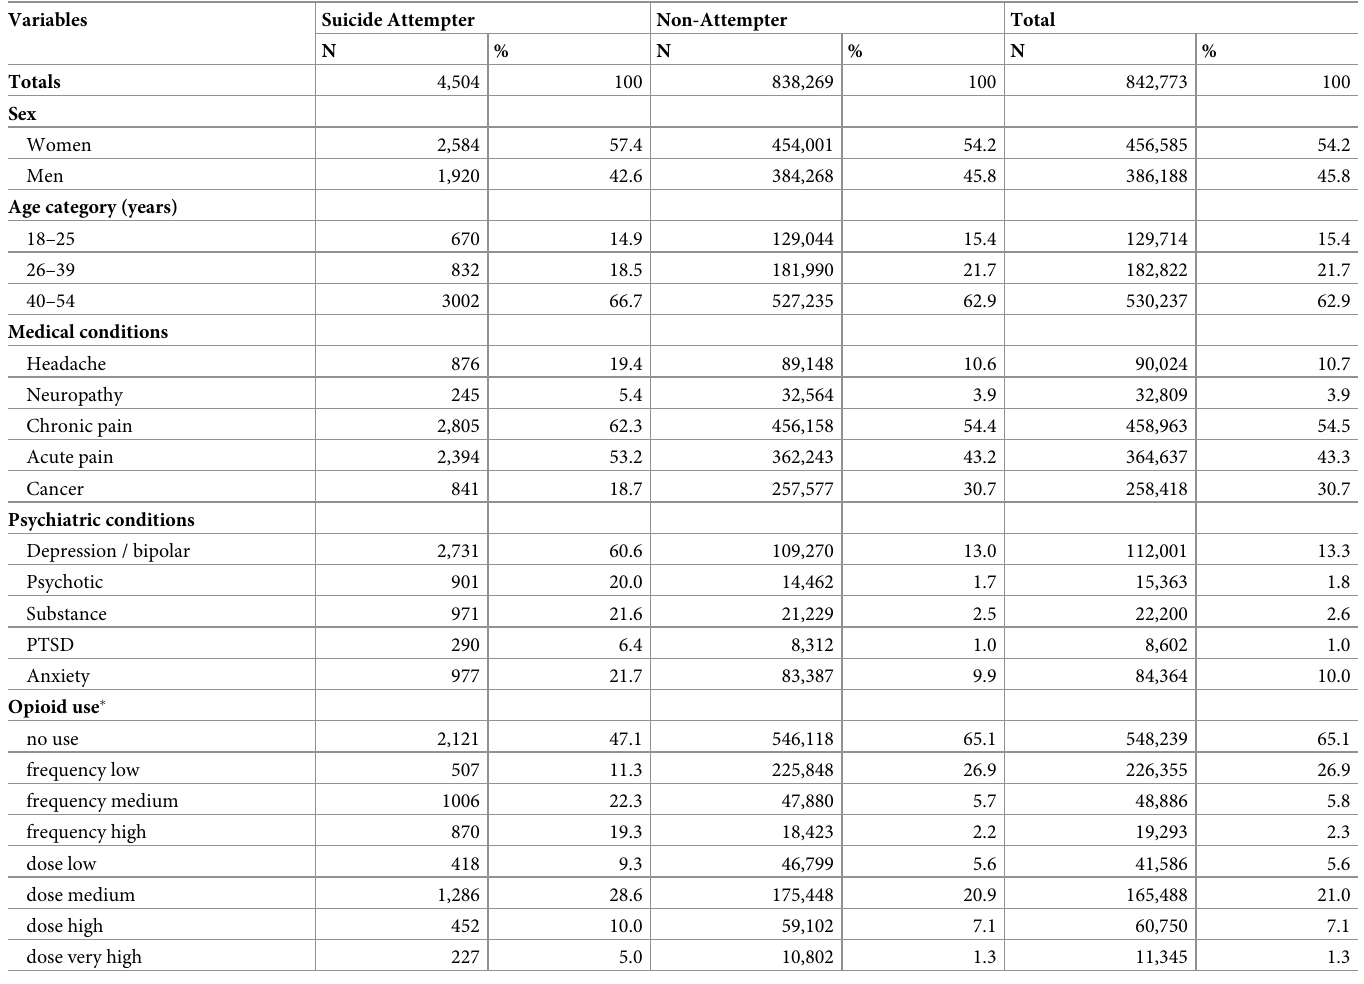
Table 1. Demographic characteristics and medical and psychiatric conditions among the study population (N =